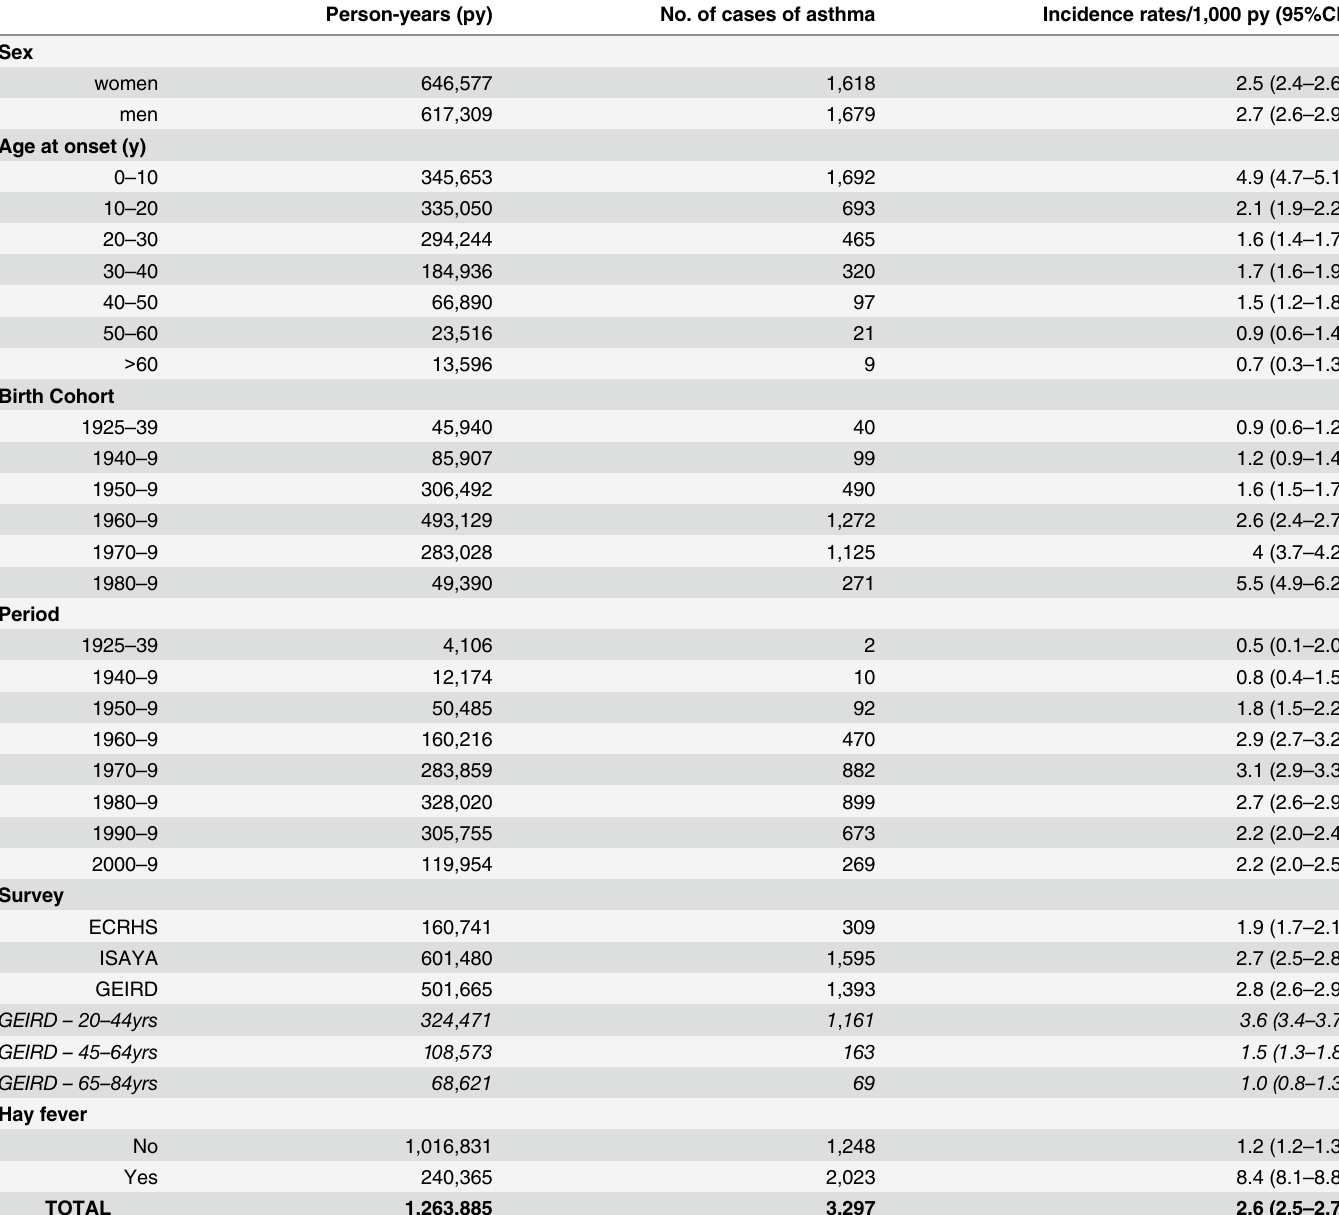
Table 1. Person-years, number of subjects reporting ever having had asthma, and the crude incidence (95%CI) of asthma by sex, age at onset, birth cohort, and period, type of study and presence of hay